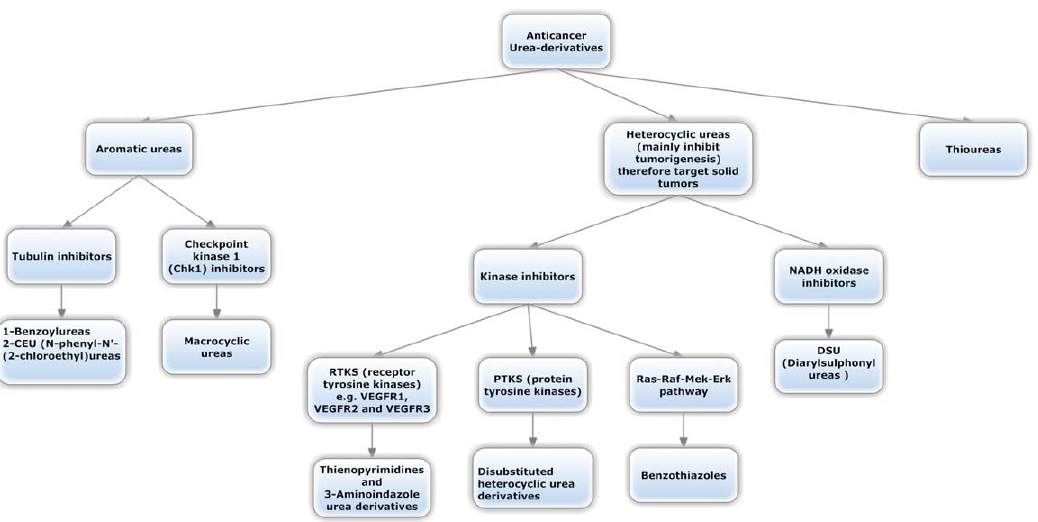
Figure 1. Classification of urea-based antineoplastic kinase inhibitors according to the general chemical structure and highlighting the general mechanism.